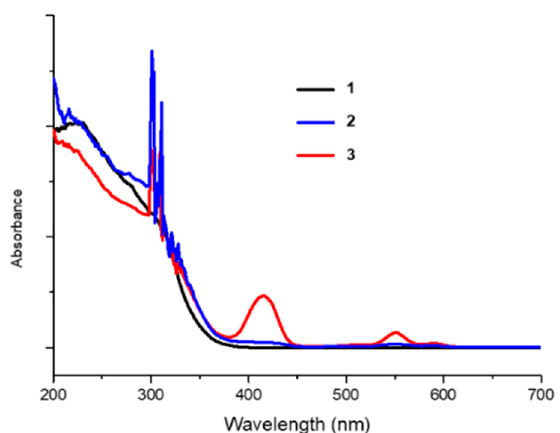
Figure 3. UV-vis absorption spectra of platinized TiO 2 ( 1 ), Nafion-coated Pt-TiO 2 ( 2 ), and SnP 6+ - embedded Nafion/Pt-TiO 2 ( 3 ) measured in solid state.